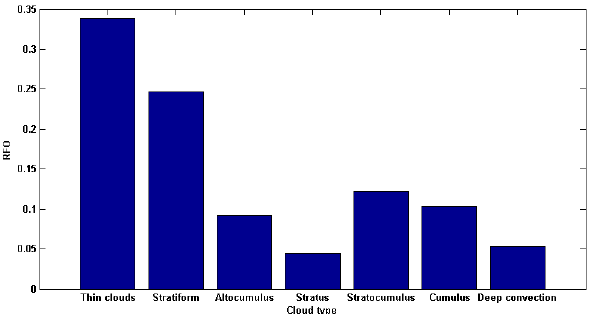
Figure 2. The relative frequency of occurrence (RFO) of different cloud types over the Indian subcontinent based on 2B-CLDCLASS- LIDAR product for 2006–2010.